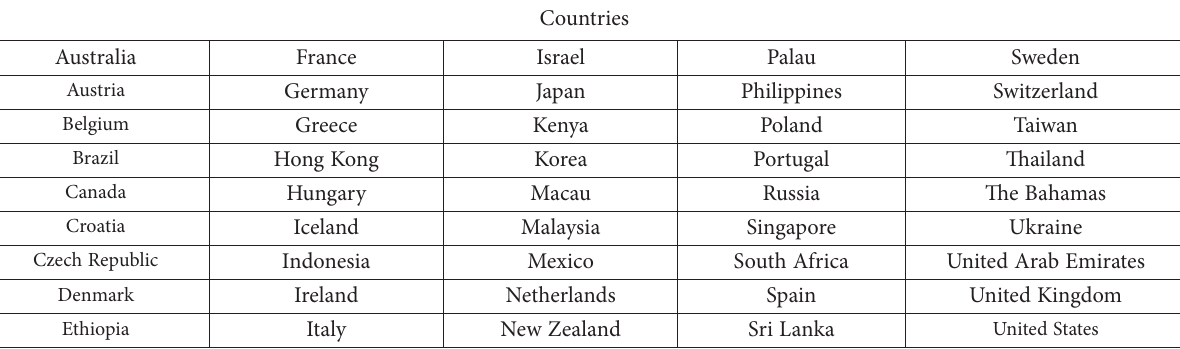
Table A1. List of sample countries &